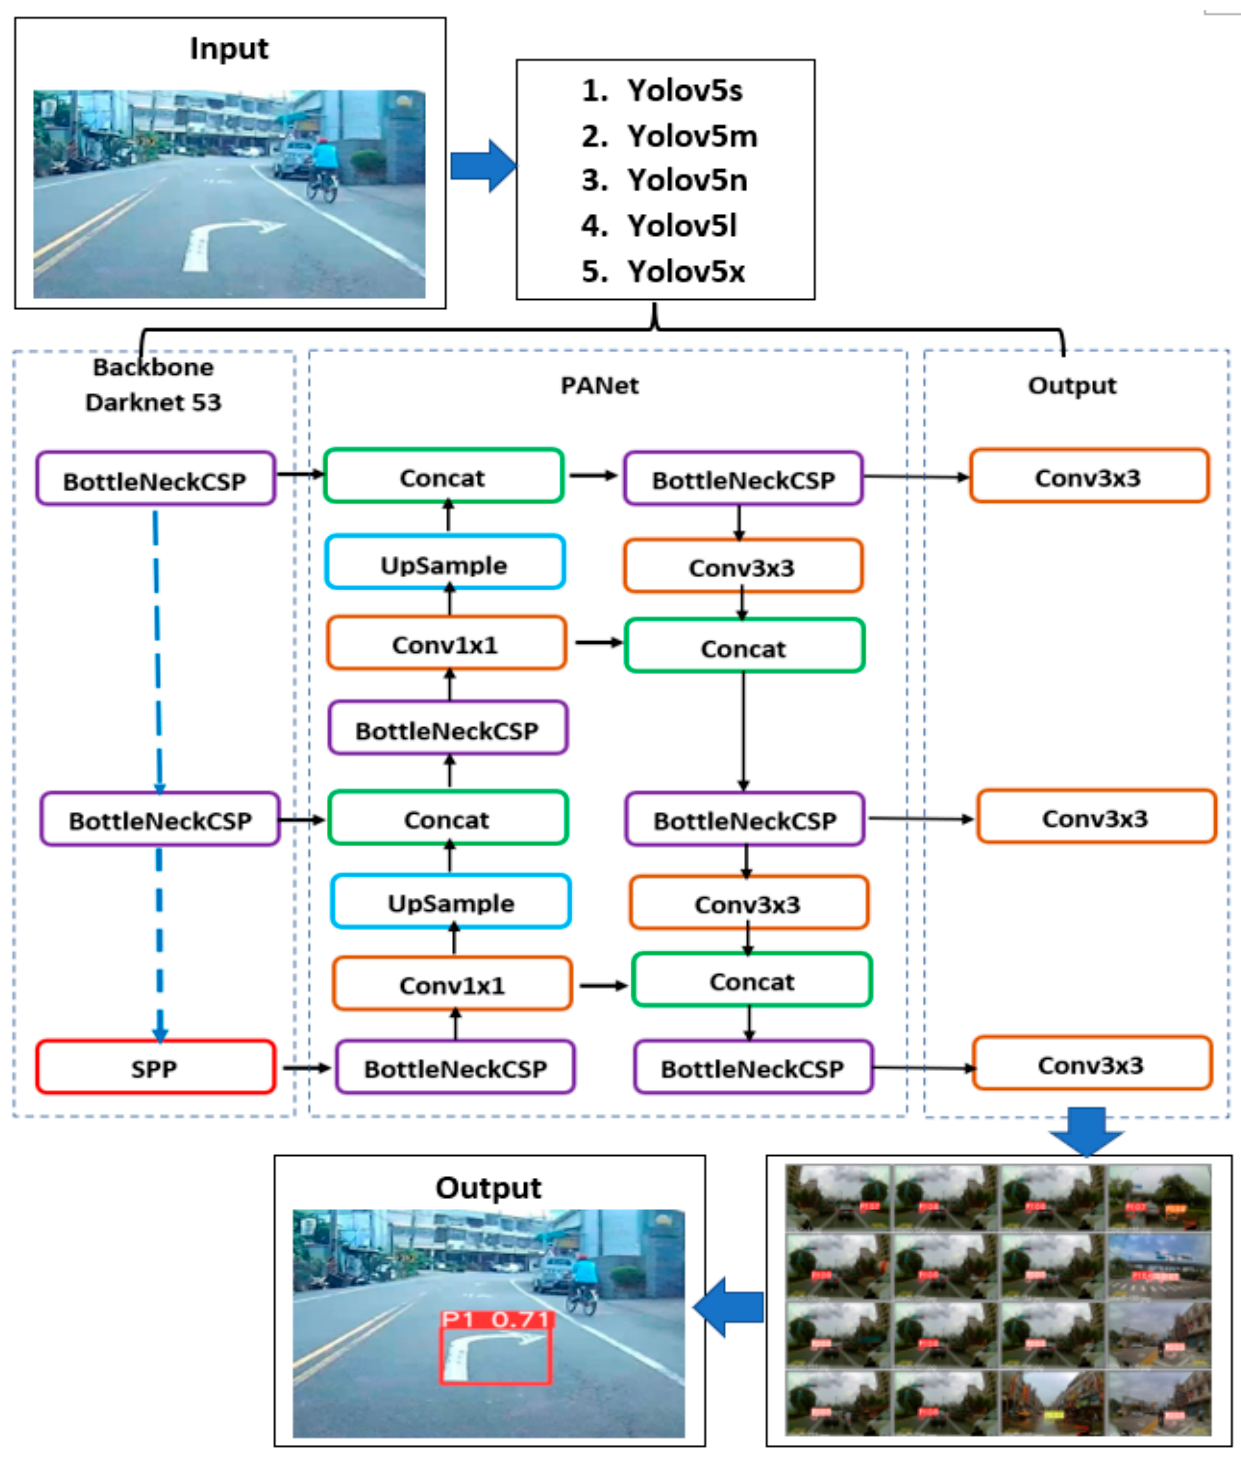
Figure 1. Yolov5 architecture.